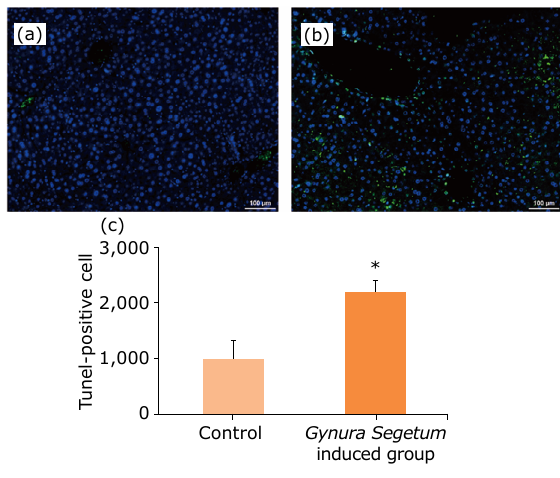
Figure 5 - Gynura segetum induced hepatocellular apoptosis in mice (TUNEL assay) (n=10). Liver specimens were collected at five weeks after G. segetum administration. Foci (green) were quantified by an Image J software. (a) control; (b) G. segetum -induced group. Original magnification ×100.